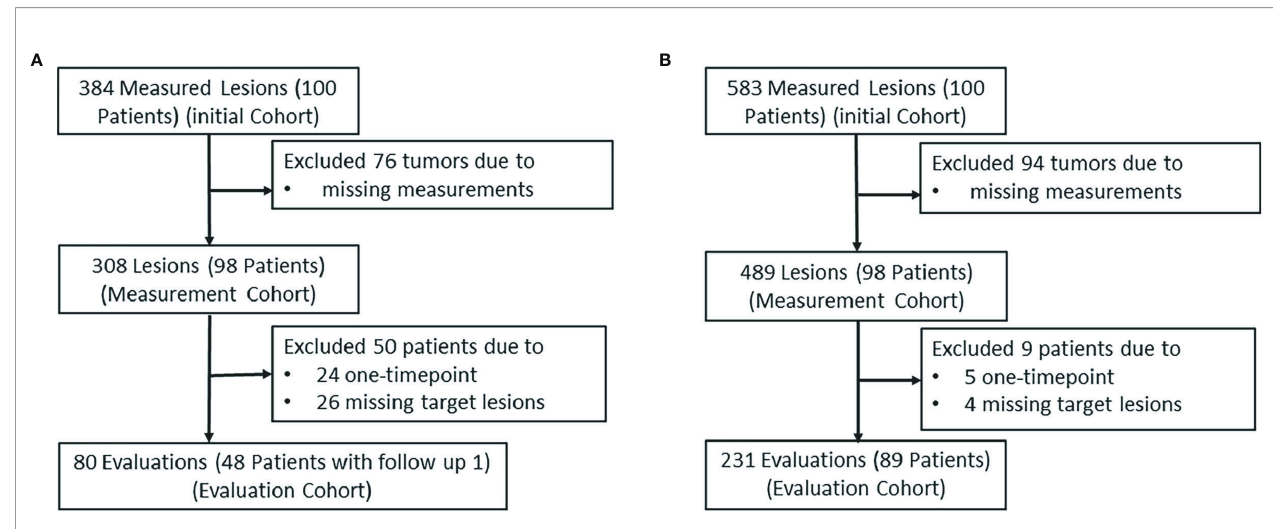
FIGURE 6 | The patient selection and distribution. The patient selection and distribution in (A) the learning study and (B) the testing